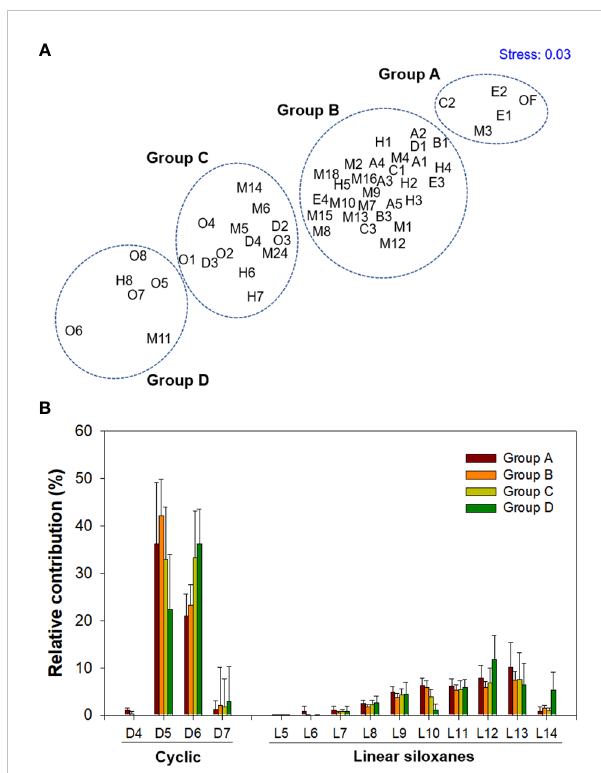
FIGURE 6 Non-parametric multidimensional scaling ( n MDS) ordination plot (A) and their respective compositional pro fi les (B) of siloxanes in sediment from Masan and Haengam Bays, offshore, and the submarine outfall of a wastewater treatment plant collected in